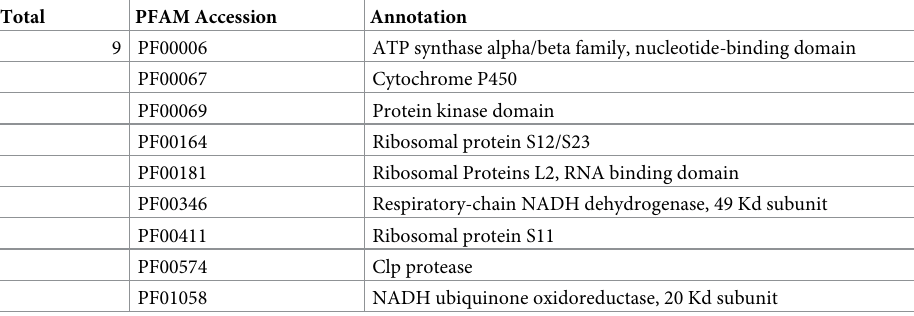
elements such as Stowaway, LINES, Cassandra, hAT-Tip100, MULE-MuDR, and helitrons were also identified in both GS and GR biotypes [S7 Table].